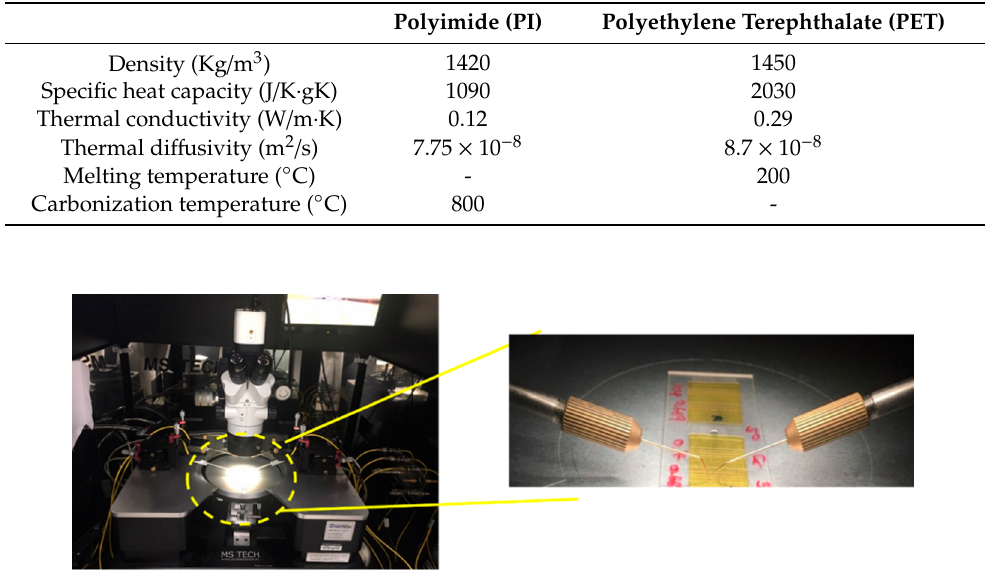
Figure 3. Photo image of the probe station equipment for measuring electrical characteristics.